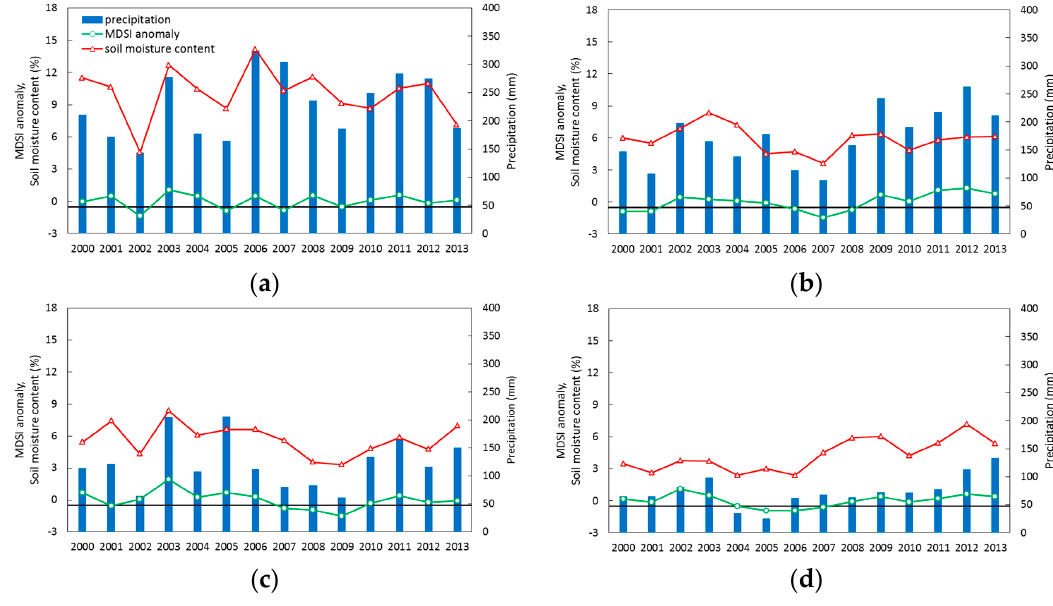
Figure 7. ( a–d ) Temporal variations of the MDSI anomaly among different land use areas for 2000–2013: ( a ) forest steppe; ( b ) steppe; ( c ) high mountains; and ( d ) desert steppe. The MDSI anomaly symbols correspond to the average of four consecutive months’ (the growing season) value calculated in the pixel region at each station. The vertical axes depict the standardized MDSI anomaly (green open circles) of the pixel region. Precipitation (mm: blue bars) is accumulated during the growing season, while soil moisture content (%: light red open triangles) is acquired during the growing season periods to match the MDSI anomaly value in the same periods. The horizontal line shows that the MDSI anomaly value − 0.5 or less for drought condition.